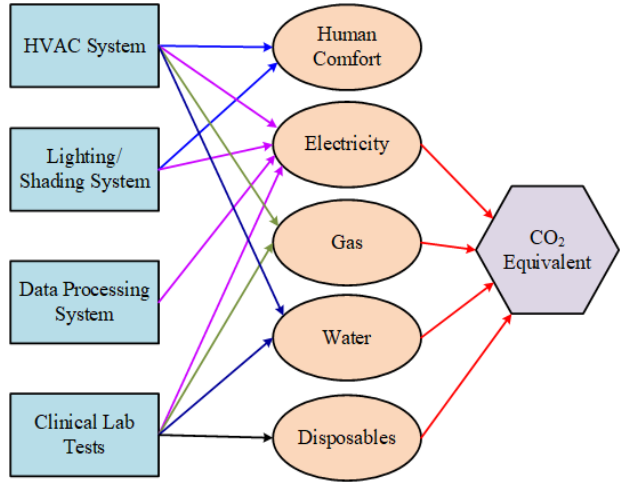
Figure 1. The relationship between clinical lab testing process and the CO 2 equivalent.